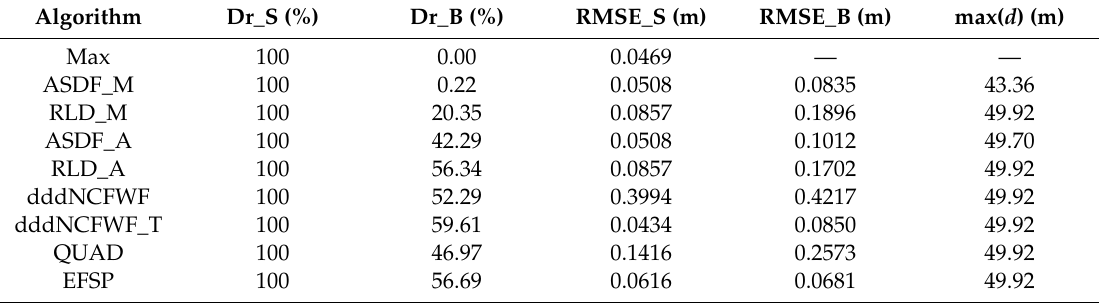
Table 5. Performance assessments for detection results in deep water with simulated